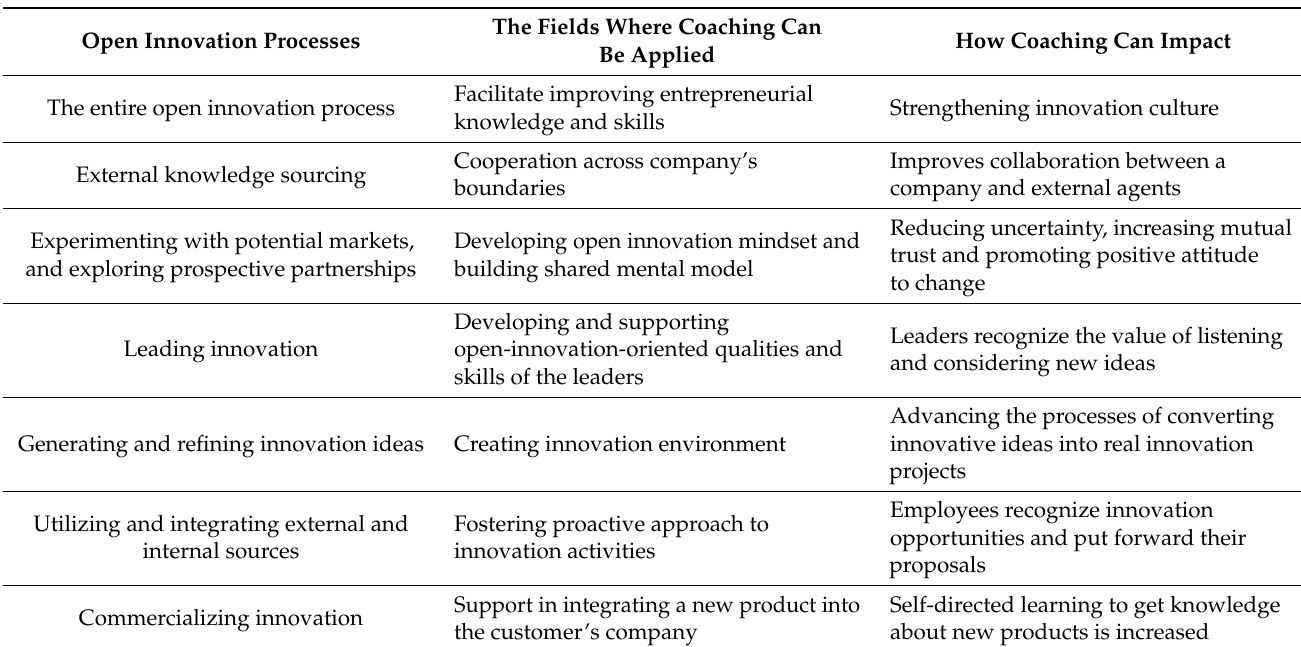
Table 1. The impact of coaching on the processes in open